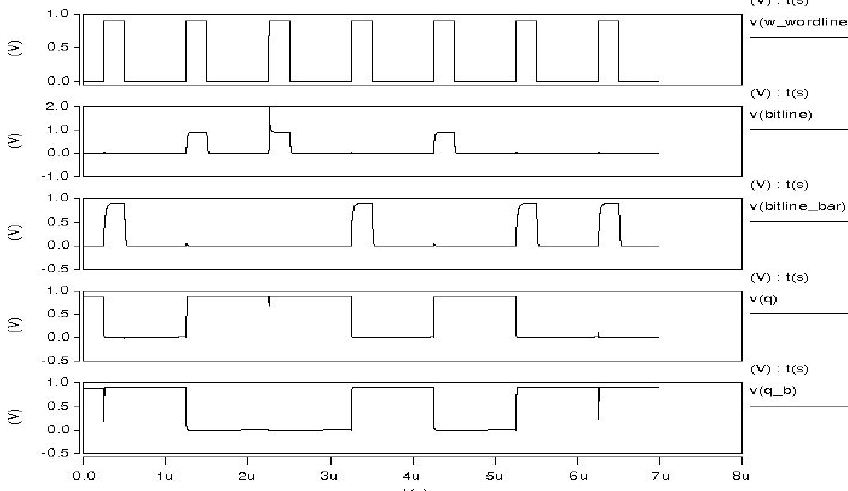
Figure 15. Waveform of write operations in FinFET (sequence of 0110100).